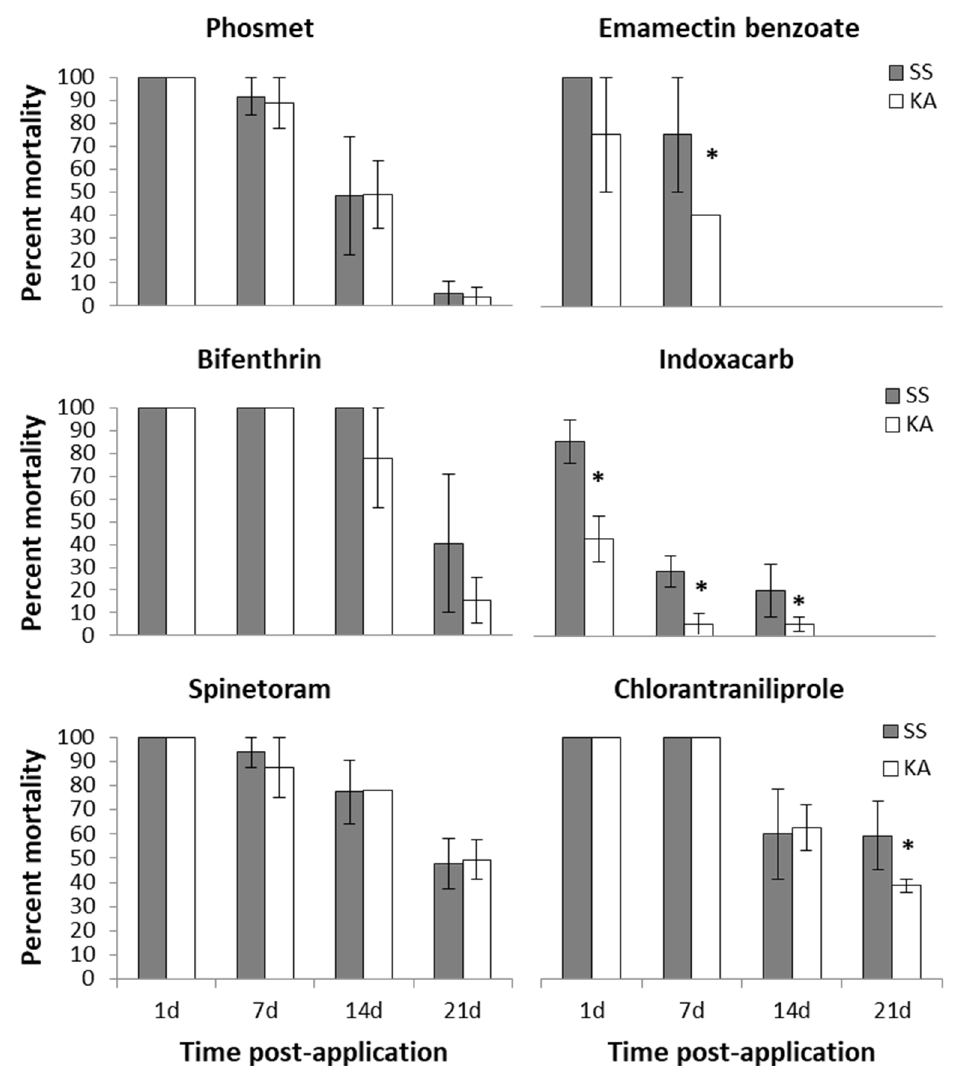
Figure 2. Mortality means ( ± SE) of the C. rosaceana 12–24 h-old larvae of the apple population (KA) and susceptible population (SS) when exposed to apple foliage collected at different post-application intervals. An asterisk (*) means the mortality of the apple population is significantly different from the mortality of the susceptible population at a given post-application interval ( α = 0.05).